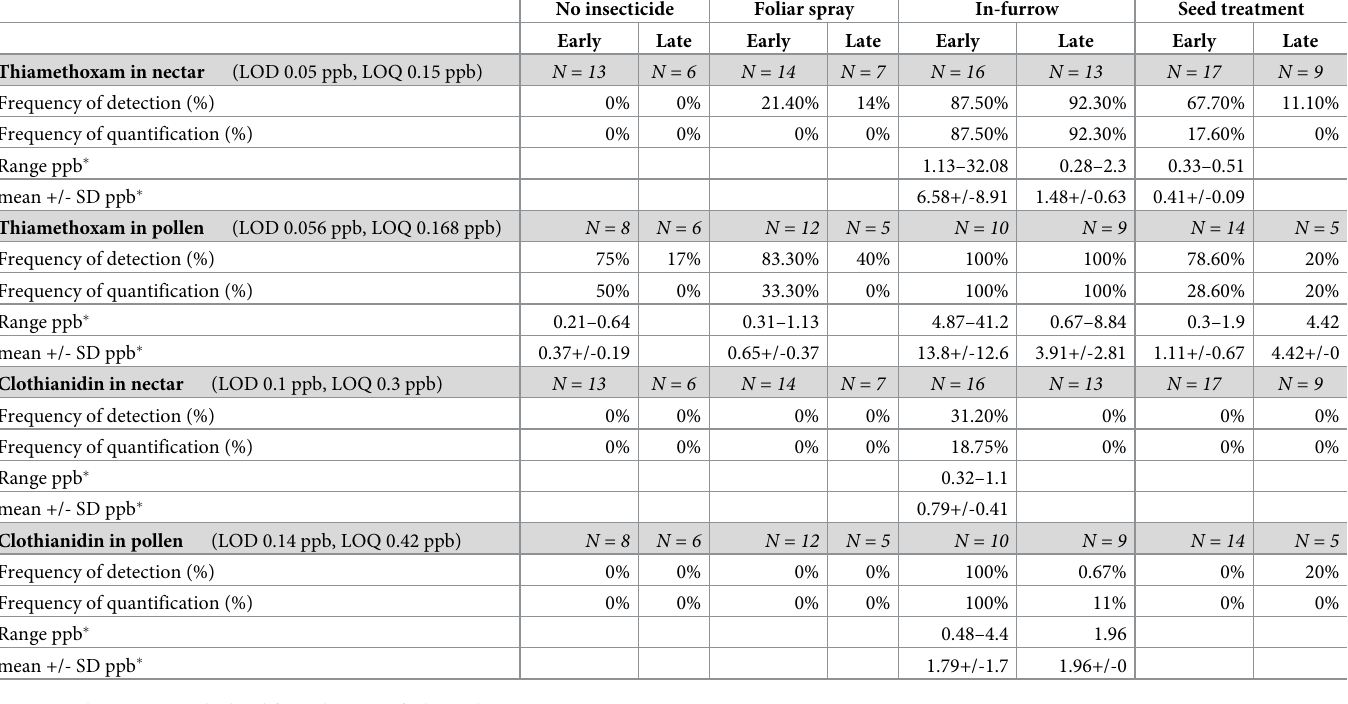
Table 3. Thiamethoxam and clothianidin residues found in nectar and pollen from early flowering (July) and late flowering (August) in squash plants treated with different thiamethoxam application